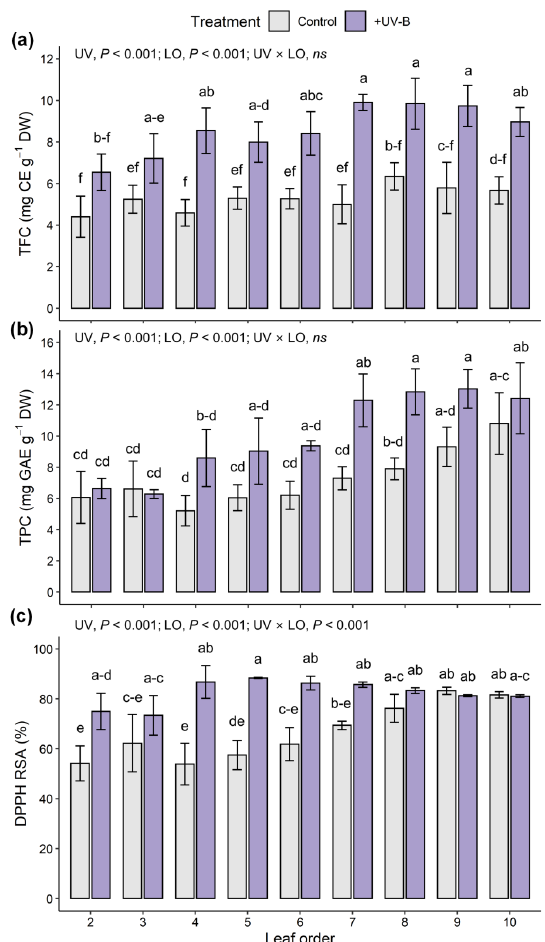
Figure 3. Total flavonoid content (TFC, ( a )), total phenolic content (TPC, ( b )), and antioxidant capacity represented as DPPH radical scavenging activity (DPPH RSA, ( c )) of individual leaves of kales in the control and UV-B treatments. Leaf order indicates the leaf developmental age in order from the oldest leaf at the bottom to the youngest leaf at the top in a whole plant. The p -value in two-way ANOVA was represented with UV treatment (UV) and leaf order (LO) and interactions. ns , nonsignificance. Different letters indicate significant differences at p < 0.05 for each parameter ( n = 3, mean ± SD) following two-way ANOVA and Tukey’s HSD test.